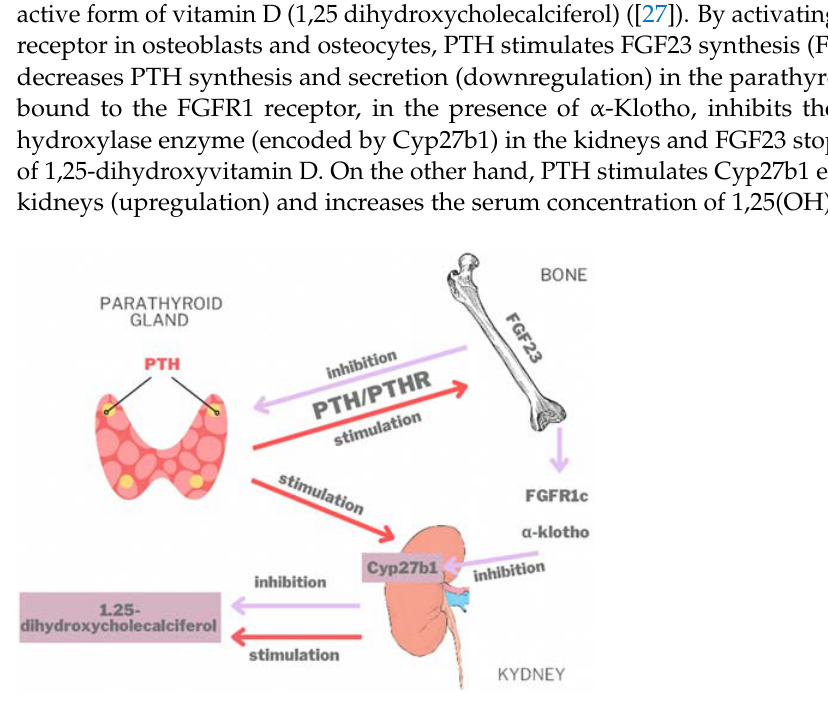
Figure 5. The role of FGF23 in circulation; PTH-parathormone; PTHR-receptor of